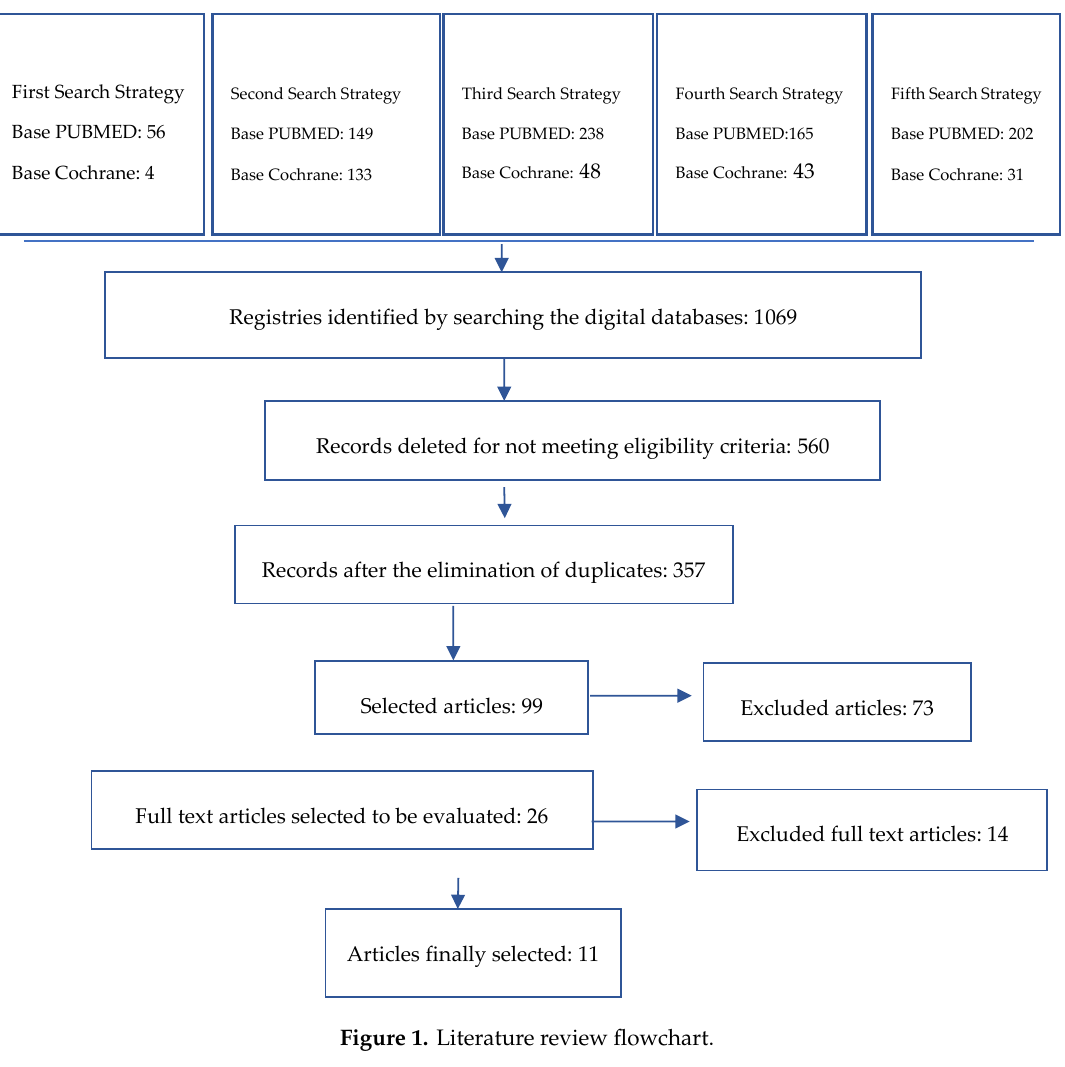
Table 2. Bond strength of etch and rinse 3-step systems